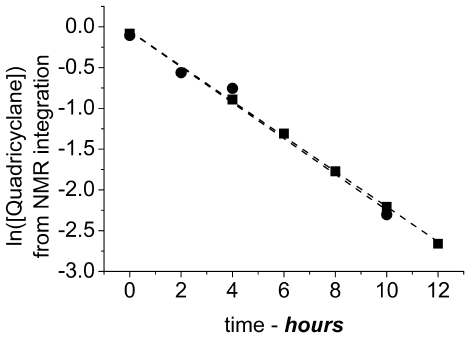
Figure 5. Kinetic traces of the formation of norbornadiene 9 in chloroform (squares) and benzene (circles) from time lapse 1 H NMR spectra. The liniear fi t to the data points are shown as dashed